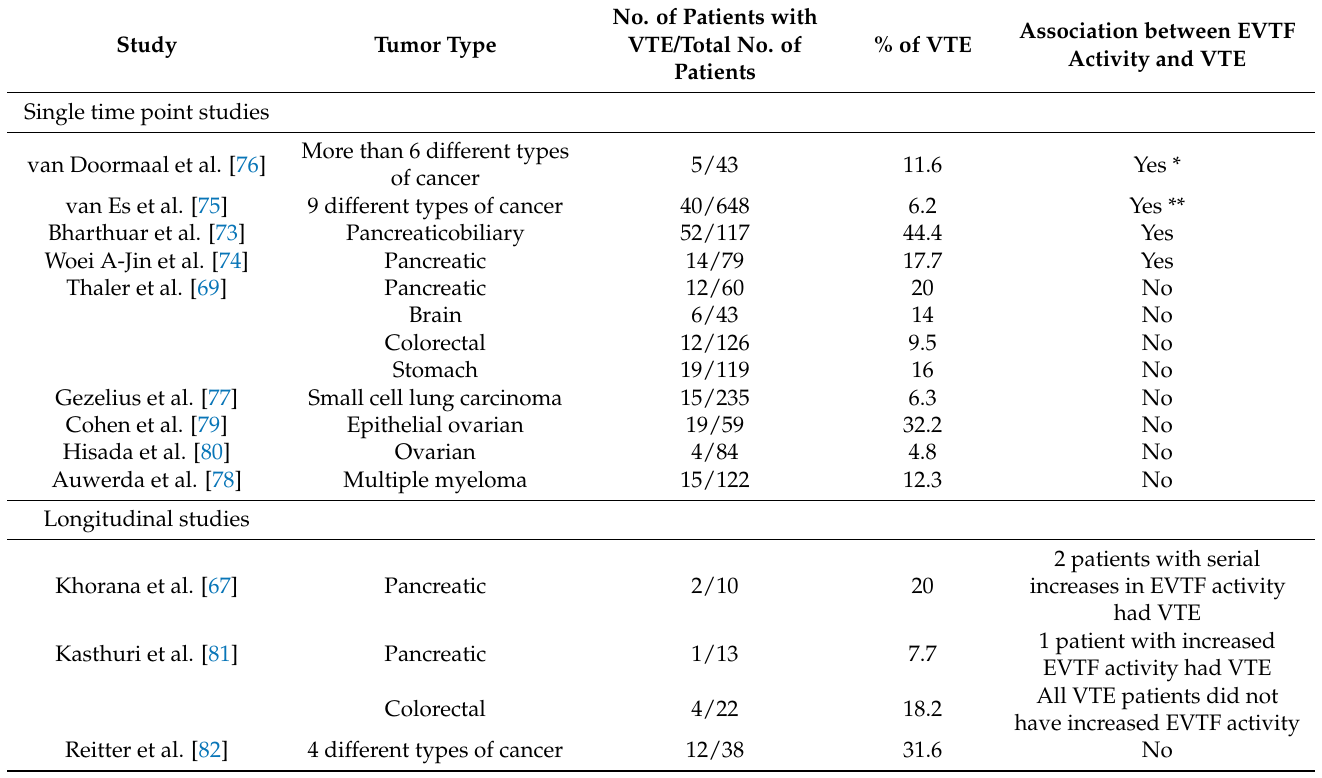
Table 1. Studies evaluating the association between extracellular vesicle tissue factor activity and venous thromboembolism in patients with